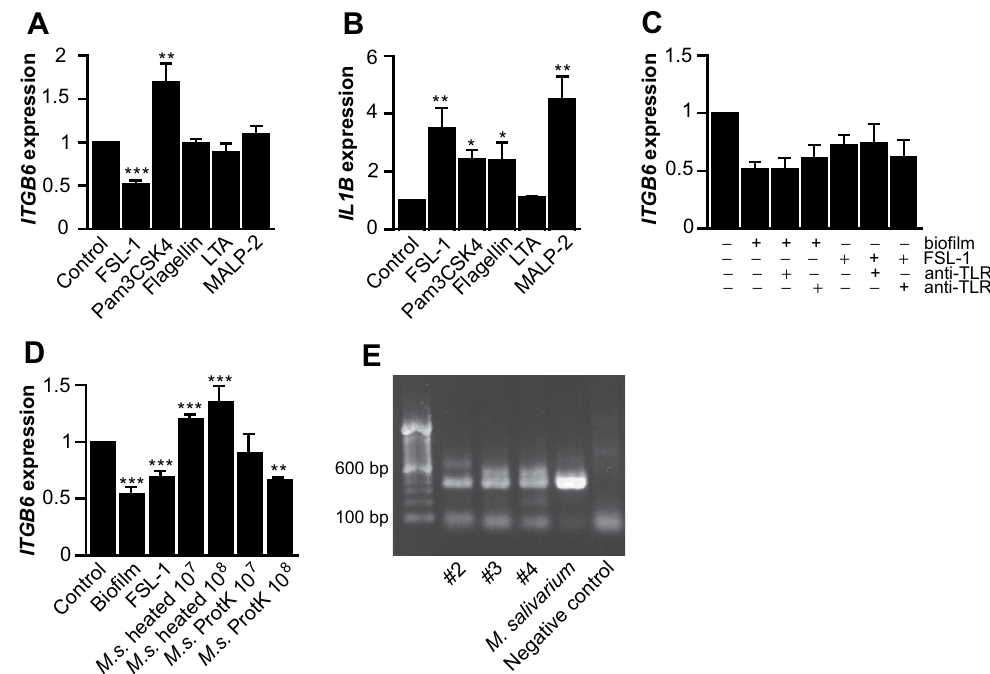
Figure 5. The role of TLR ligands in the downregulation of β 6 integrin in GECs. ( A ) and ( B ) GECs were treated with FSL-1 (100 ng/ml; n = 4), Pam3CSK4 (300 ng/ml; n = 4), flagellin (100 ng/ml; n = 3), LTA (2 µ g/ml; n = 3) or MALP-2 (100 ng/ml; n = 3) or left untreated for 32 h, and their effect on ITGB6 ( A ) and IL1B expression ( B ) was analyzed by RT-qPCR. Mean ± SEM is presented. ( C ), GECs were pre-treated with anti-TLR2 and anti-TLR6 blocking antibodies for 1 h, after which heated biofilm extract (60 µ g protein/ml) or FSL-1 (100 ng/ ml) was added for 32 h. ITGB6 expression was analyzed by RT-qPCR. Mean ± SEM is presented (n = 3–5). ( D ) GECs were treated with heated Mycoplasma salivarium extract (10 7 or 10 8 cfu/ml) with or without proteinase K digestion for 32 h and their ITGB6 expression was analyzed by RT-qPCR. Heated biofilm extract (60 µ g protein/ ml) and FSL-1 (100 ng/ml) were used as positive controls. Mean ± SEM of three experiments is presented. * p < 0.05; ** p < 0.01; *** p < 0.001. ( E ) Mycoplasma was detected in oral bacterial biofilms (#2, #3 and #4 shown) by PCR and agarose gel electrophoresis. M. salivarium and water were used as a positive and negative control,